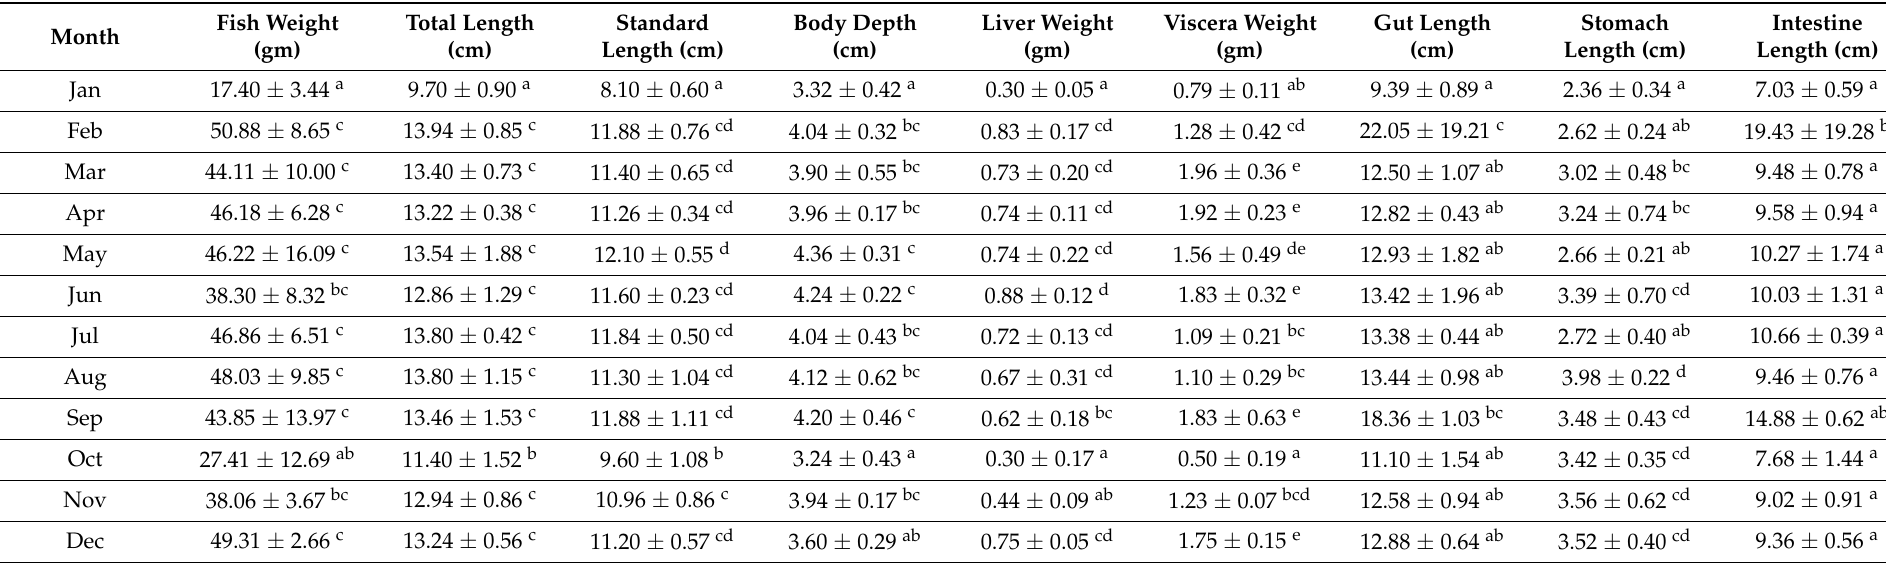
Table 1. Biometrical and gastrointestinal parameters of wild N. nandus in the Kawadighi